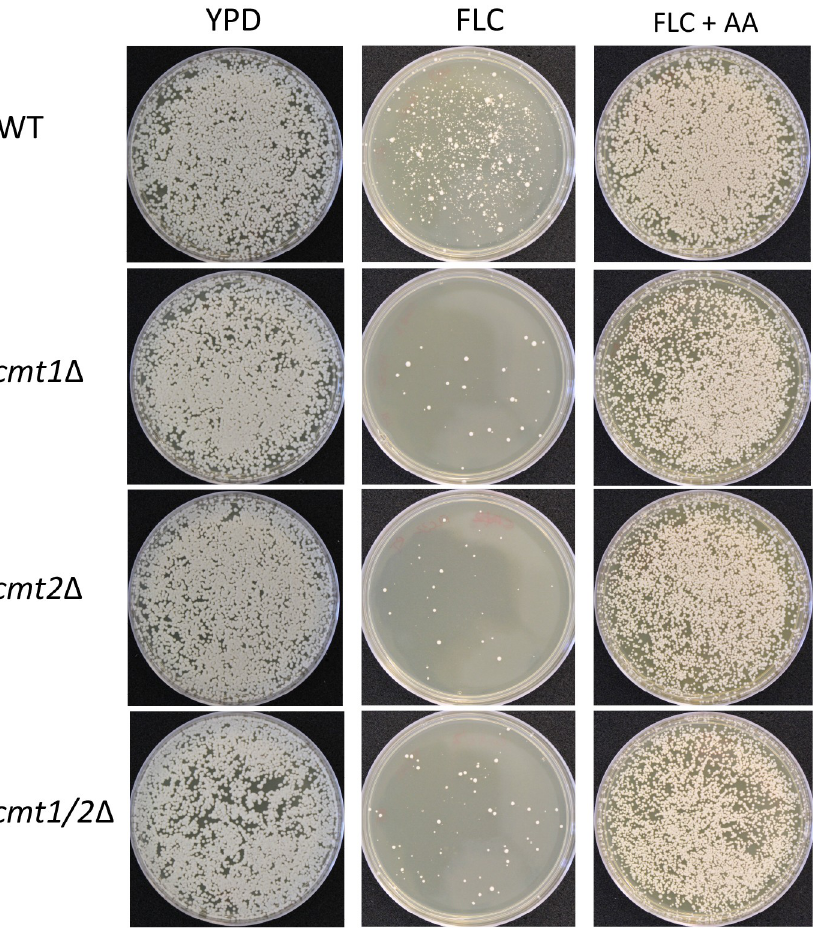
Fig 5. Anti-oxidant effects of ascorbic acid on C . neoformans H99 and cmt1 Δ , cmt2 Δ and cmt1/2 Δ strains upon fluconazole treatment. Approximately 10,000 cells were plated on YPD and YPD supplemented with 32 μ g/ml FLC with or without 10 mM ascorbic acid